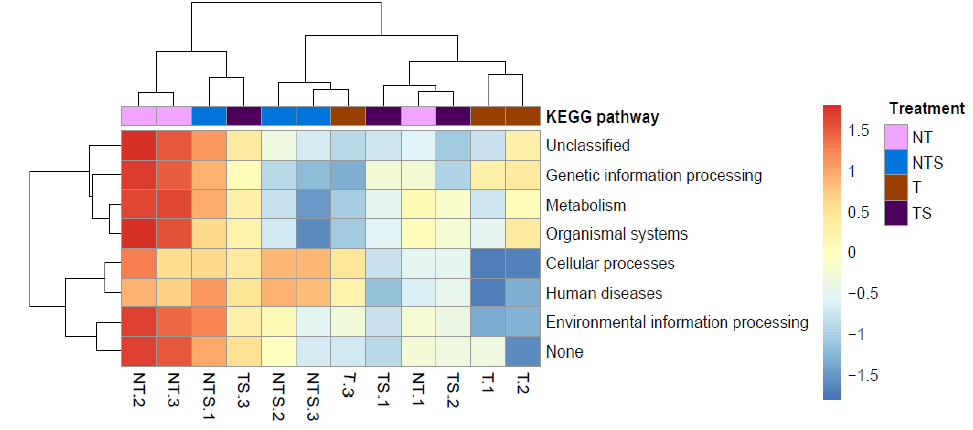
Figure 4. Clusters showing the relative abundance of soil bacterial community predicted functions related to KEGG pathways at level one as affected by tillage and crop residue management treatments. NT, no-tillage with all crop residue removed at harvest; NTS, no-tillage with crop residue chopped and spread evenly on the soil surface; T, conventional tillage with all crop residue removed at harvest; TS, conventional tillage with all crop residue chopped, spread evenly on the soil surface, and incorporated into the soil via plowing. Table 3. Relative abundance of soil bacterial community top four predicted functions related to KEGG pathways at level two as affected by tillage and crop residue management treatments.